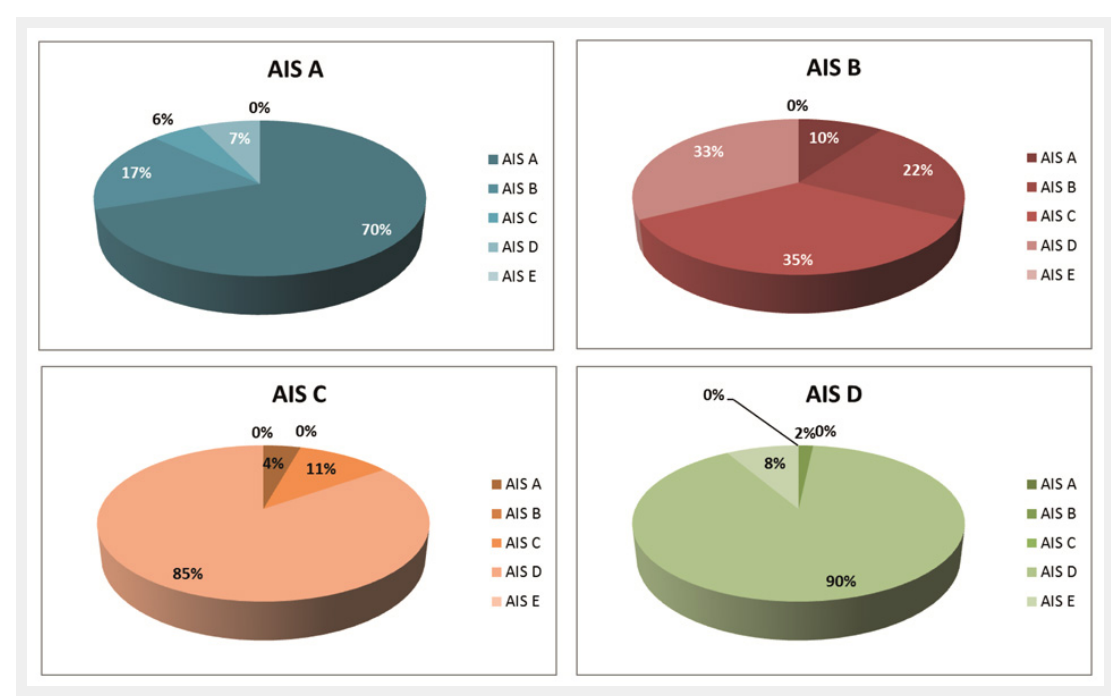
Conversion in neurological status after SCI. The percentage of patients that convert to another neurological category according to the International Standards for Neurological Classification of Spinal Cord Injury differs widely between the categories AIS A (sensory-motor complete), AIS B (motor complete, but sensory incomplete), AIS C and D, both sensory-motor incomplete, but AIS D patients have more than half of the muscles underneath the lesion graded as 3 or above. Conversion is largest in AIS B and C patients and smallest in AIS D patients. (Numbers are based on